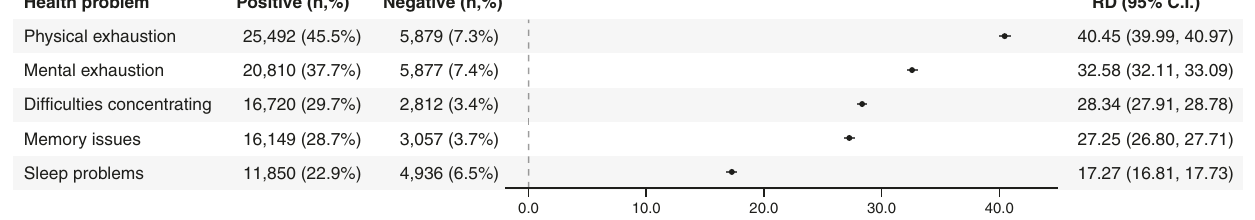
Fig. 3 Risk differences of self-reported health problems with new onset between the test date and until 6 – 12 months after, comparing SARS-CoV-2 test-positive and test-negative participants. Note: Bars indicate risk differences (center) with 95% con fi dence intervals (length of error bars) adjusted for age, sex, comorbidities, obesity, healthcare occupation, and time after testing (in months). For health problems with onset between the test date and until 6 – 12 months after the test date, all test negatives no matter of the indication for testing are used as control population. All symptom questions were mandatory, so for all lines the proportions are based on 61,002 test-positive and 91,878 test-negative individuals. An individual could only participate in the study once, as either test-positive or test